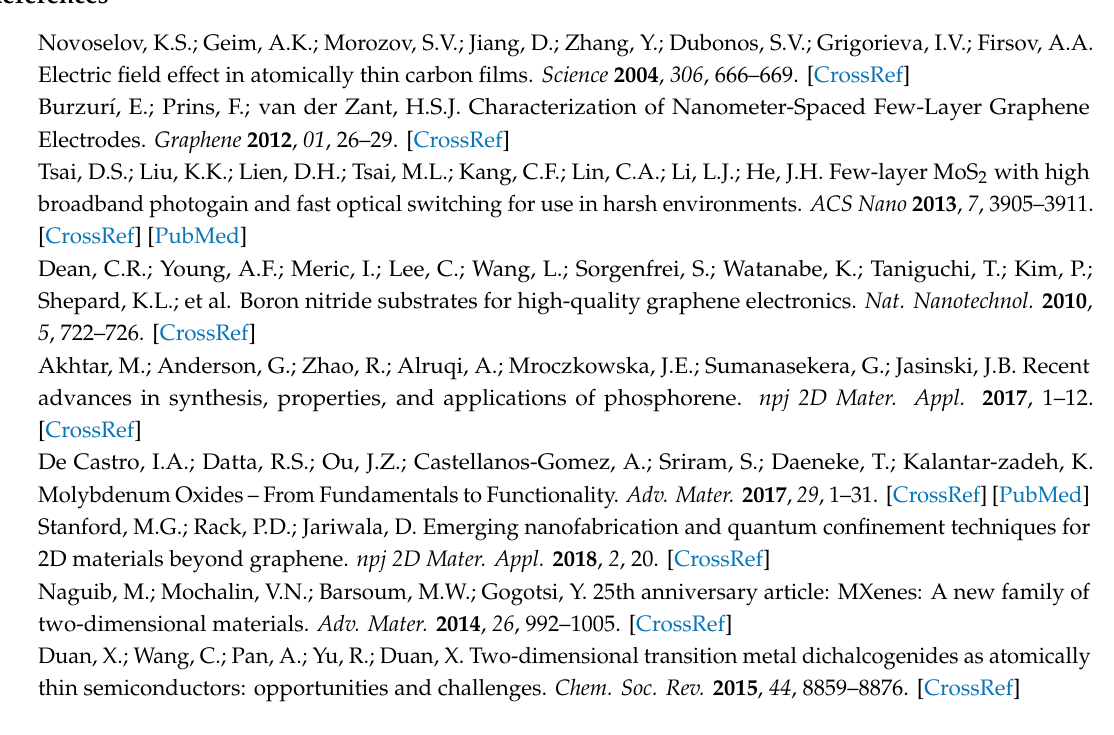
Figure S1: Color-chart of MoO 3 on SiO 2 / Si with 148 nm of SiO 2 capping layer, Figure S2: Color-chart of MoO 3 on SiO 2 / Si with 271 nm of SiO 2 capping layer, Figure S3: (a) Index of refraction of MoO 3 films, SiO 2 and Si materials. These values are obtained from bibliography [56–59] and they are in accordance with our spectroscopic ellipsometry measurements. (b) Index of refraction (n) and extinction coe ffi cient ( κ ) measured by ellipsometry on a pollycrystalline α -MoO 3 film transferred onto a SiO 2 / Si substrate with 280 nm of SiO 2 thickness layer, Figure S4: Calculated optical contrast dependence on illumination wavelength and SiO 2 thickness for a monolayer MoO 3 on a SiO 2 / Si